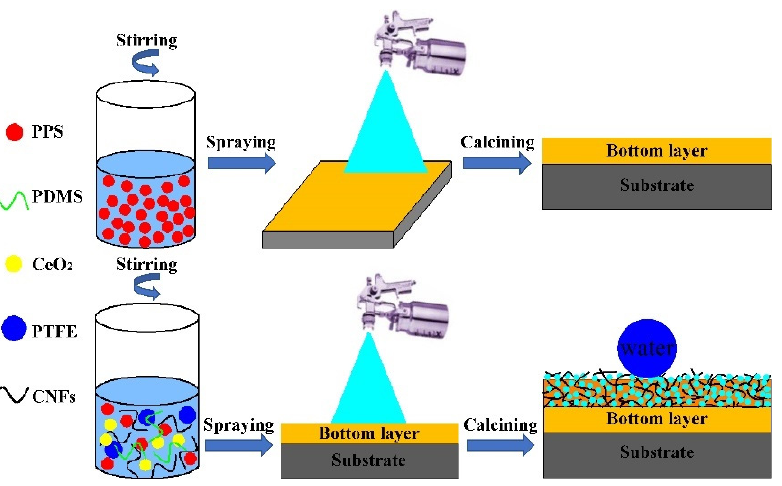
Figure 1. Schematic diagram of the preparation process for conductive superhydrophobic compo- Schematic diagram of the preparation process for conductive superhydrophobic site coating. composite